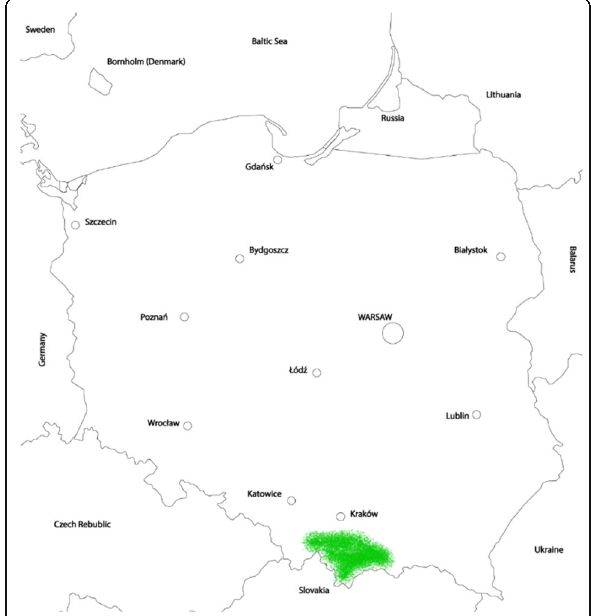
Figure 1 Study area on a map of Poland. Based on map from http://www.supercoloring.com/pl/kolorowanki/mapa-polski CC licence